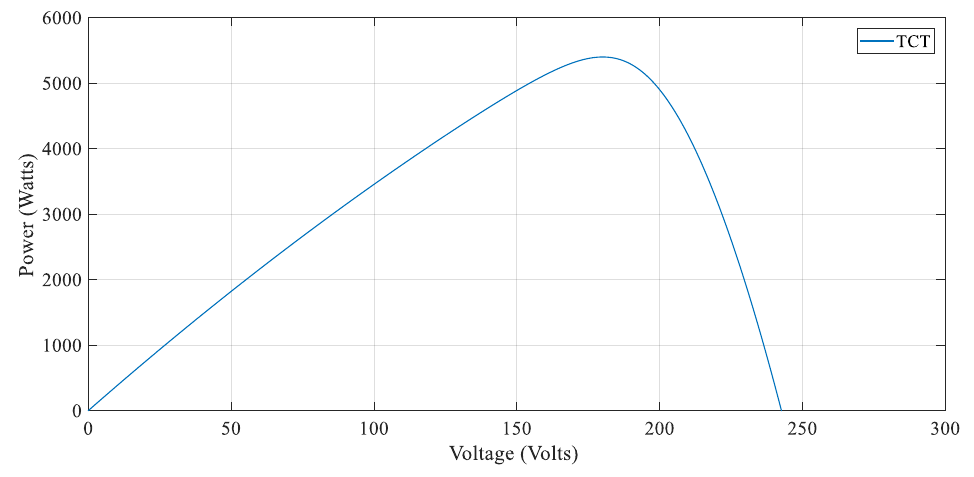
Table 6. Parameters of the PV model during open-circuit fault (F1).